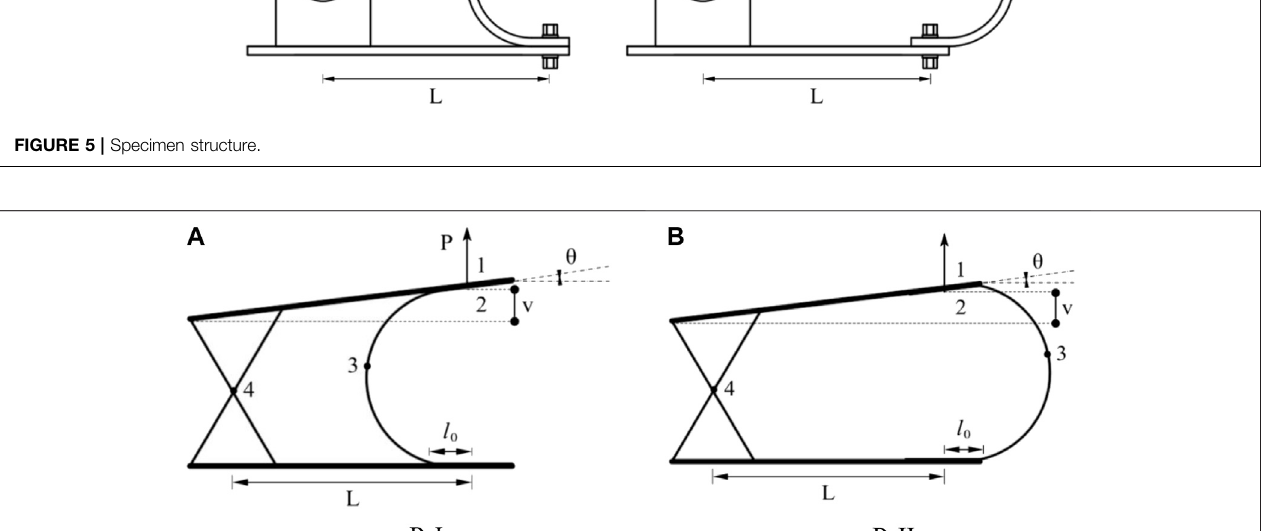
TABLE 1 | Test specimens.